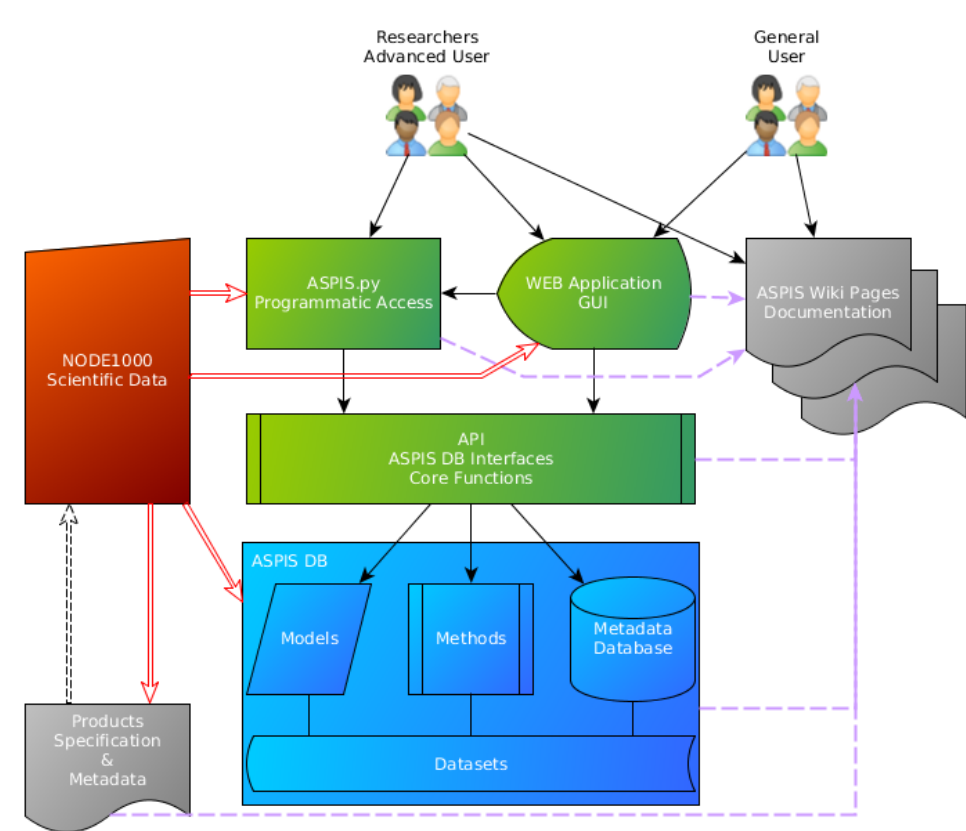
Figure 5. ASPIS high-level architecture (see the